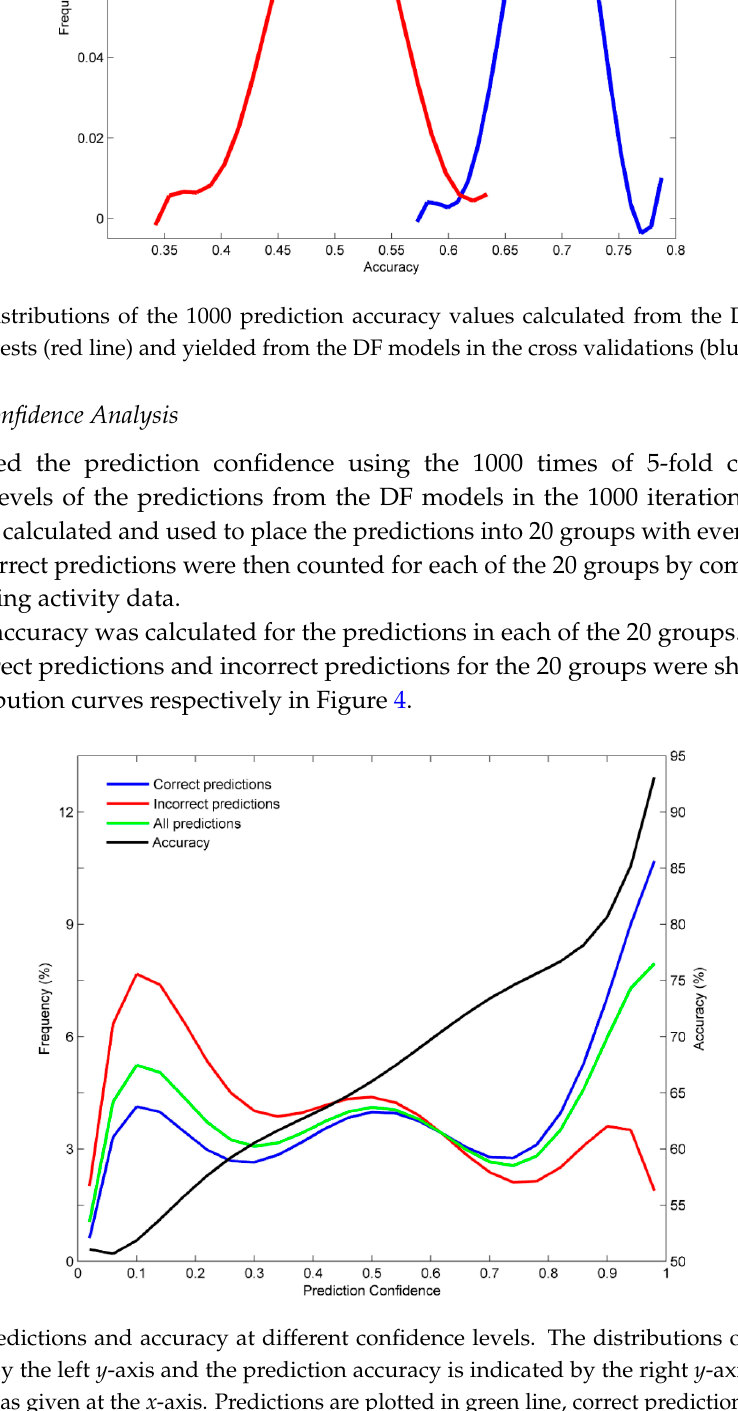
Figure 4. Predictions and accuracy at different confidence levels. The distributions of predictions were given by the left y -axis and the prediction accuracy is indicated by the right y -axis. Prediction confidence was given at the x -axis. Predictions are plotted in green line, correct predictions in blue line, incorrect predictions in red line, and prediction accuracy in black line.